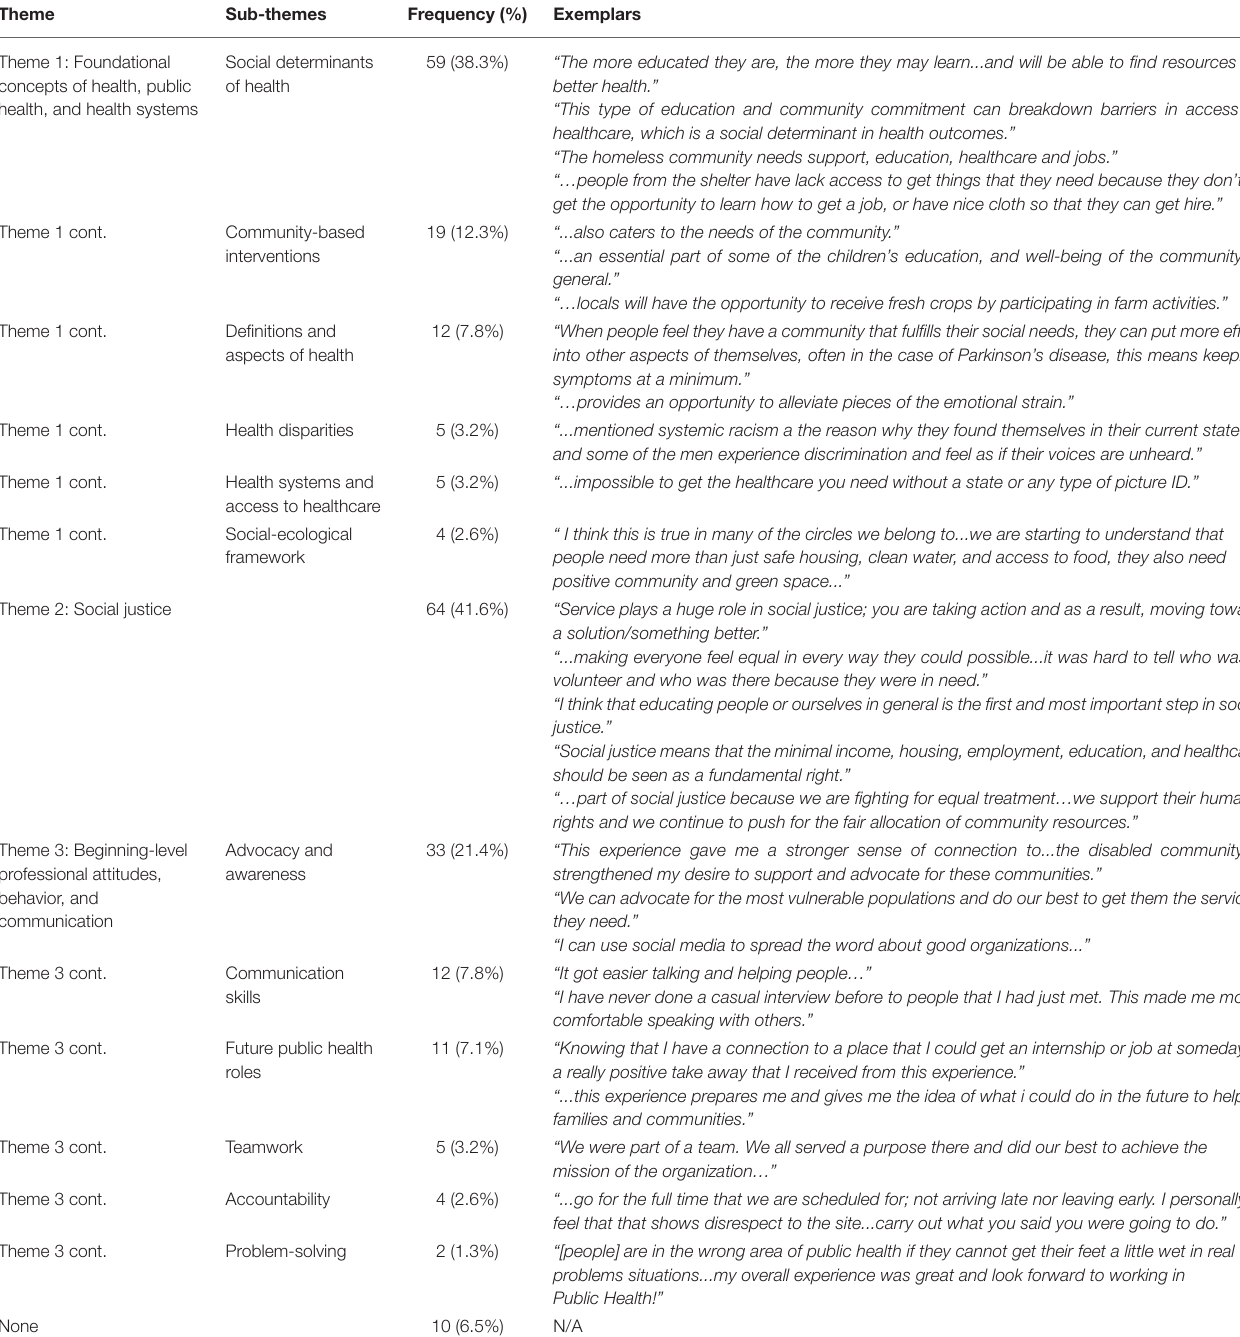
TABLE 2 | Frequency and exemplar quotes of themes and sub-themes that demonstrate the support of experiential learning to didactic public health education in Foundations of Public Health (Fall 2015–Spring